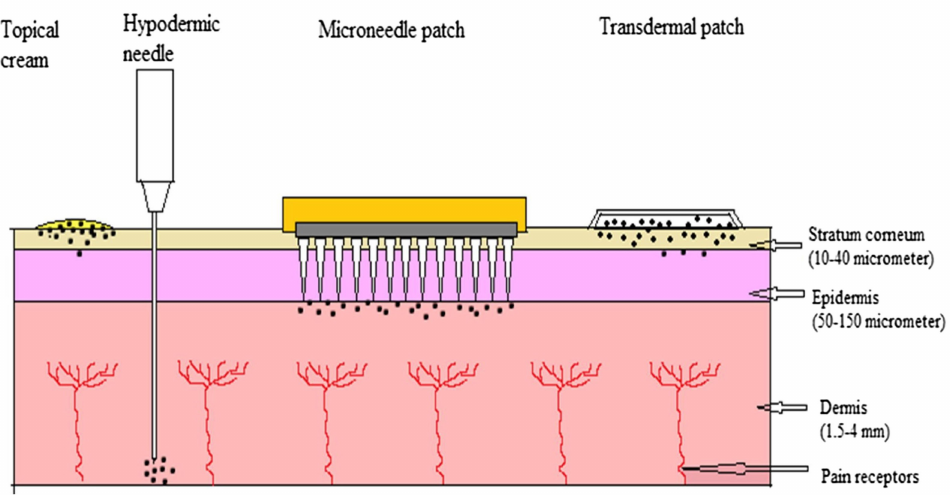
Figure 1. Different types of transdermal drug delivery systems [16]. Reprinted from Biomedicine & Pharmacotherapy, Vol. 109, Tejashree Waghule et al., Microneedles: A smart approach and increasing potential for transdermal drug delivery system, Pages 1249–1258, Copyright (2019), with permission from